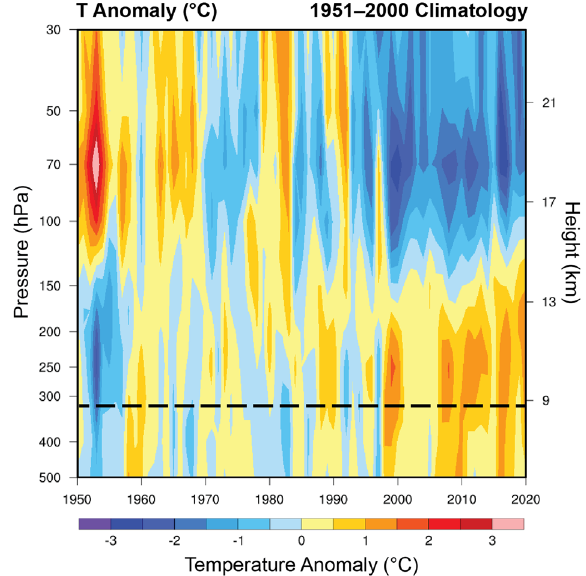
Fig. 3 Temperature vs pressure and height. Time/height pro fi les over Mt. Everest for temperature (2 m). The dashed line indicates the approximate level of Mt. Everest summit. Annual anomalies are relative to 1951 – 2000 climatology. Data from the European